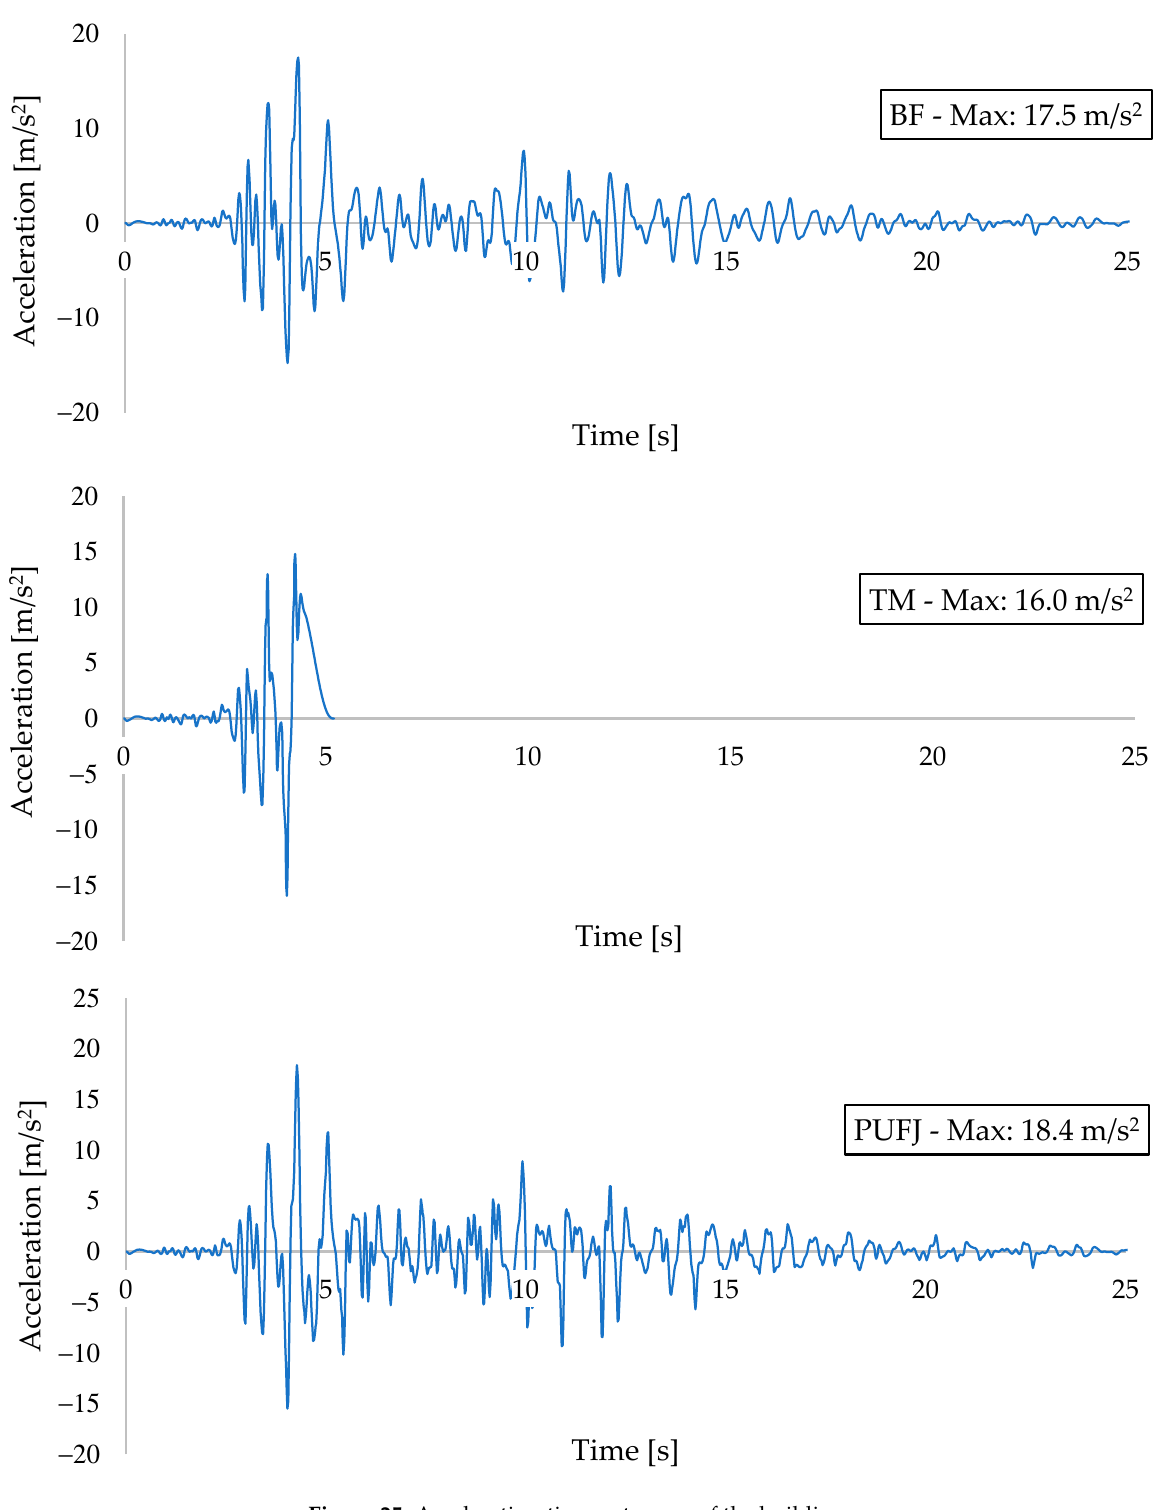
Figure 25. Acceleration-time outcomes of the buildings.